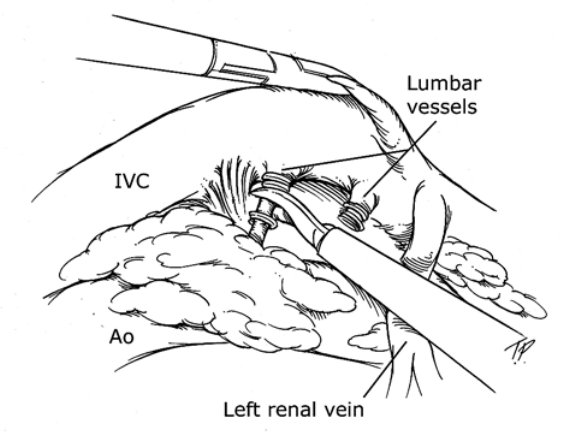
Figure 7 – At the end of the dissection, we can observe that all lymph node tissues inside the template limits have been removed, with preservation of the sympathetic chains along the postero- lateral aspect of the great vessels. IVC = inferior vena cava, Ao =